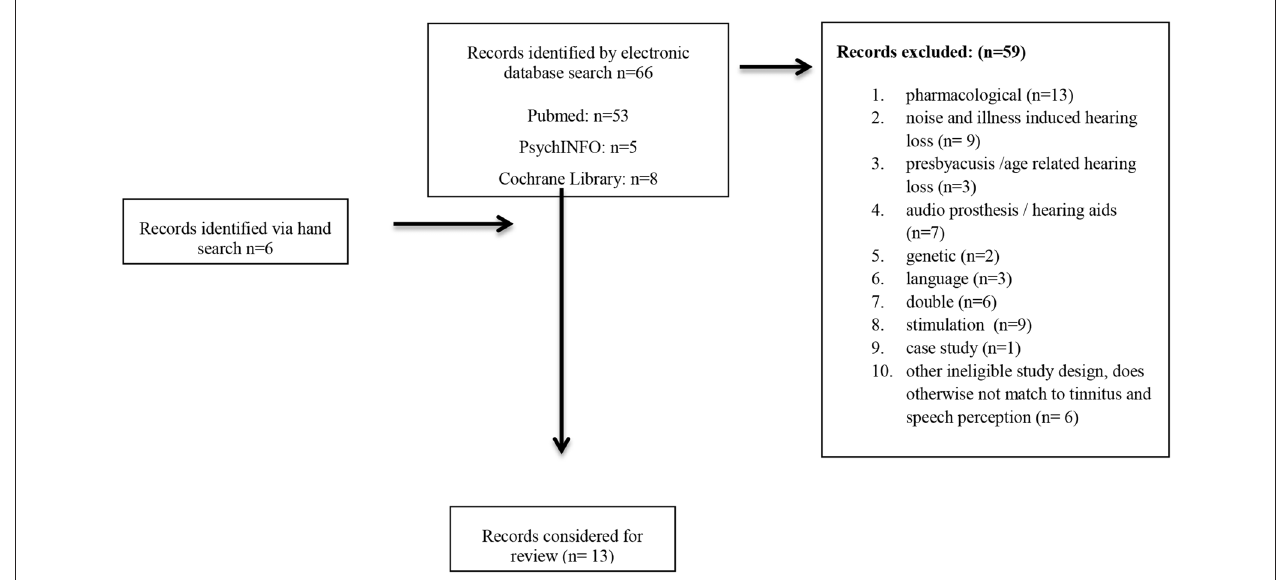
FIGURE 1 | Flow chart for the identification of studies included in the